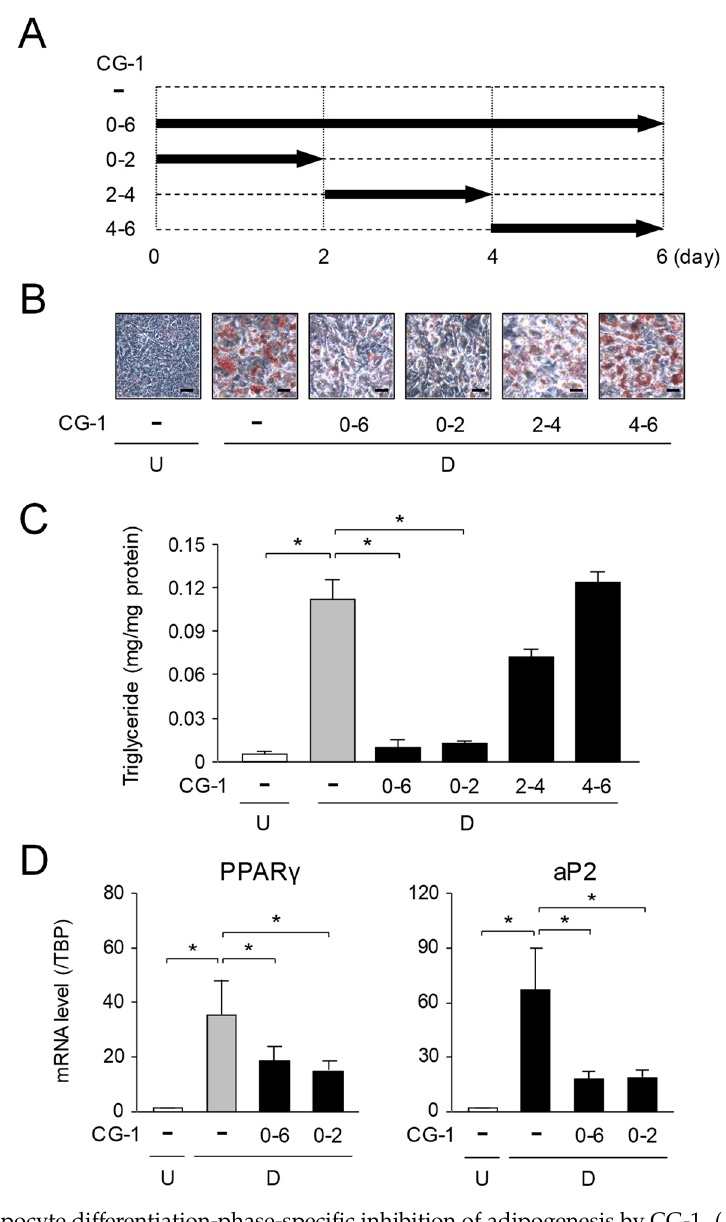
Figure 4. Adipocyte di ff erentiation-phase-specific inhibition of adipogenesis by CG-1. ( A ) Addition of CG-1 into the medium at the indicated time-points in 6-days-adipogenesis. ( B ) Oil Red O staining of lipid droplets in phase-specific CG-1-treated 3T3-L1 cells. The cells (undi ff erentiated cells: U) were di ff erentiated into adipocytes (di ff erentiated cells: D) in DMEM with CG-1 (10 µ M) during days 0–6, 0–2, 2–4, or 4–6 of 6-days-adipogenesis. Data are representative of three experiments. The cells were observed by a microscope (200 × ). Scale bar = 100 µ m. ( C ) Intracellular triglyceride level in 3T3-L1 cells. The cells (undi ff erentiated cells: U; white column ) were di ff erentiated into adipocytes (di ff erentiated cells: D) in DMEM without ( gray column ) or with CG-1 (10 µ M; black columns ) during days 0–6, 0–2, 2–4, or 4–6 of 6-days-adipogenesis. Results are shown as the means ± S.D. from three experiments. * p < 0.01, as indicated by the brackets. ( D ) Suppression of adipogenesis-related gene expression in the early phase of adipogenesis. Expression level of the adipogenic genes in CG-1-treated 3T3-L1 cells. The cells (undi ff erentiated cells: U; white columns ) were di ff erentiated (D) into adipocytes in DMEM without ( gray columns ) or with CG-1 (10 µ M; black columns ) during days 0–6, 0–2, 2–4, or 4–6 of 6-days-adipogenesis. Results are expressed as the means ± S.D. from three experiments. * p < 0.01, as indicated by the brackets.